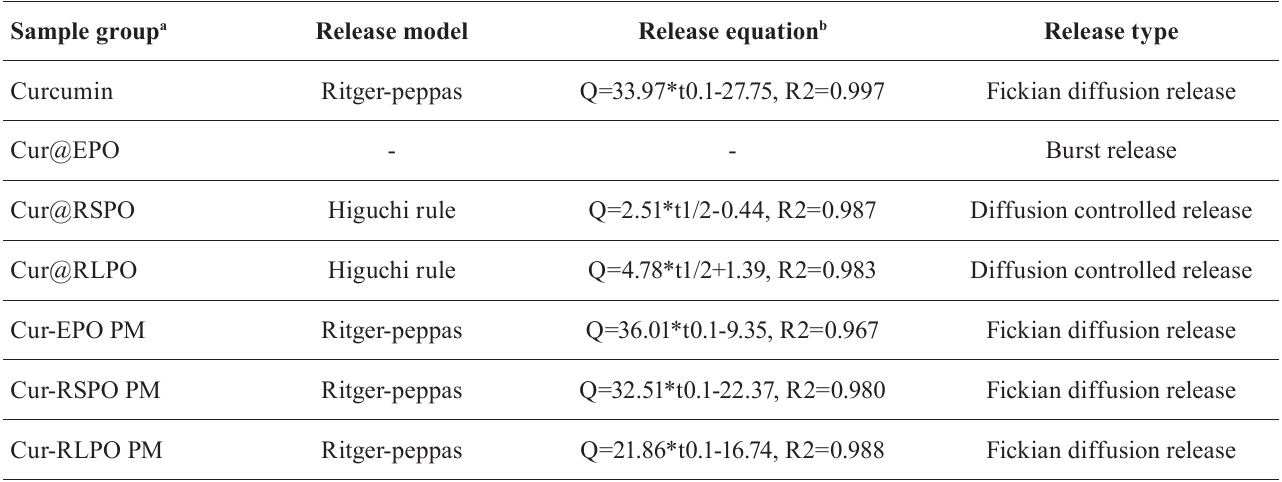
TABLE II - Release model and kinetics of curcumin, solid dispersion and physical mixture in simulated gastric fluid Sample group